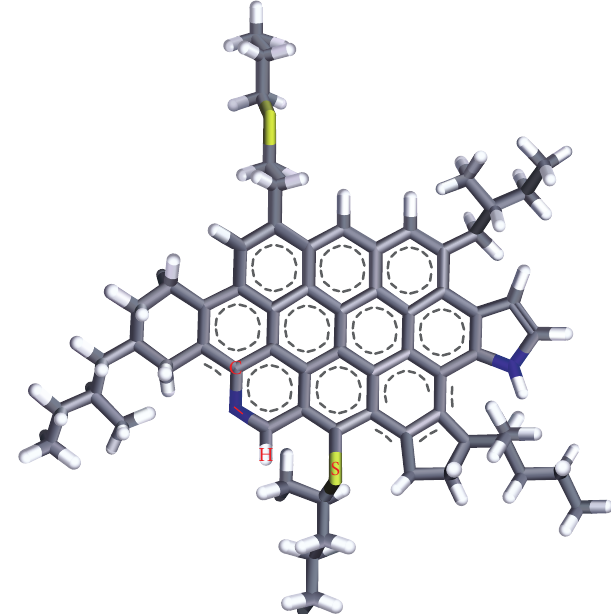
Figure 2: Average molecular structure of asphaltene.